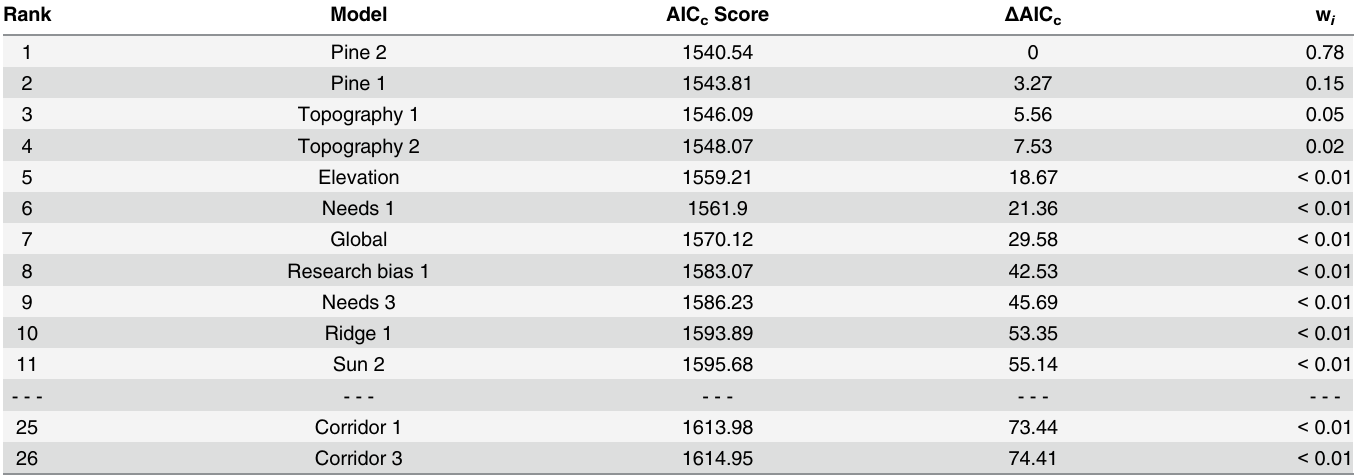
Table 3. Model rankings.